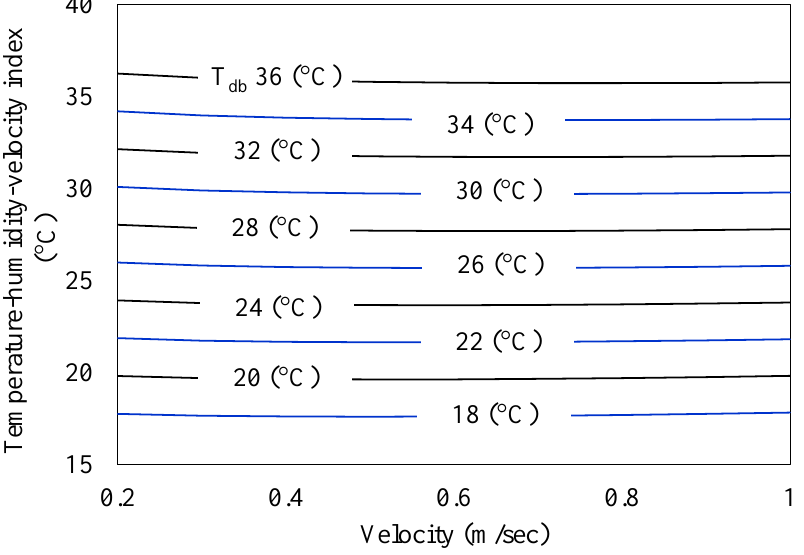
Figure 10. The variation of THVI as a function of air velocity at different T db .